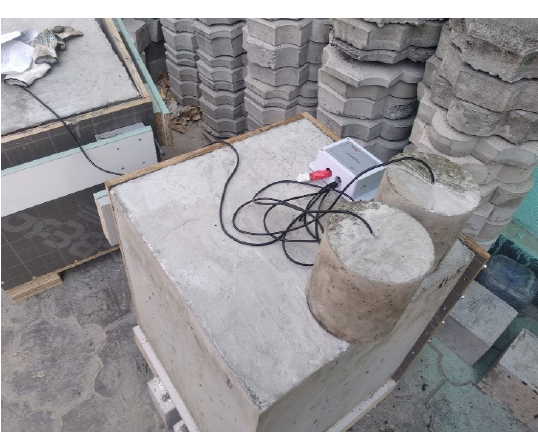
Figure 1. Testing set for estimating the concrete strength.